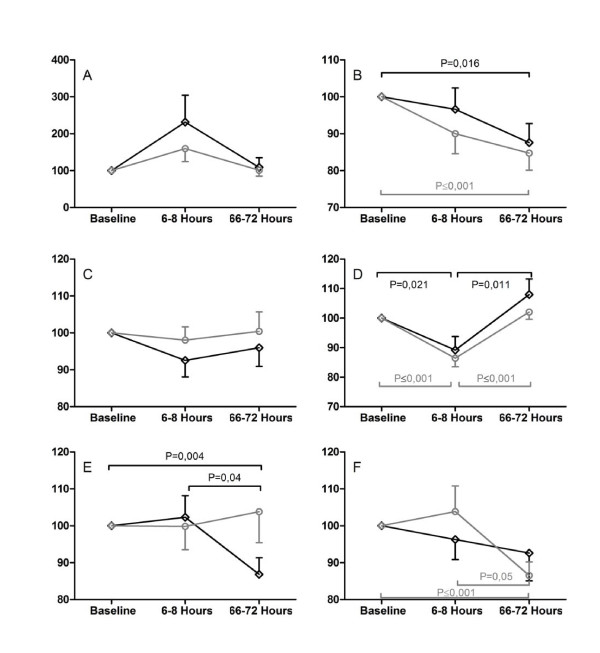
Well-being and Paper-Pencil-Tests. Well-being measured with Bf-S (A) and STAI (B), cognitive function assessed with Paper-Pencil-Tests DS (C), DSST (D), Trail Making Test A and B (E+F). An increase in percent shows a decline in well-being (A+B) and a decline in outcome for E and F. A decrease in percent in C and D shows an increase in outcome. All values are Mean (SEM) and display the change at 6-8 and 66-72 hours normalized to the preoperative baseline. All ordinates are in percent. Grey lines and open circles display the xenon group, black lines and open squares represent the sevoflurane group.